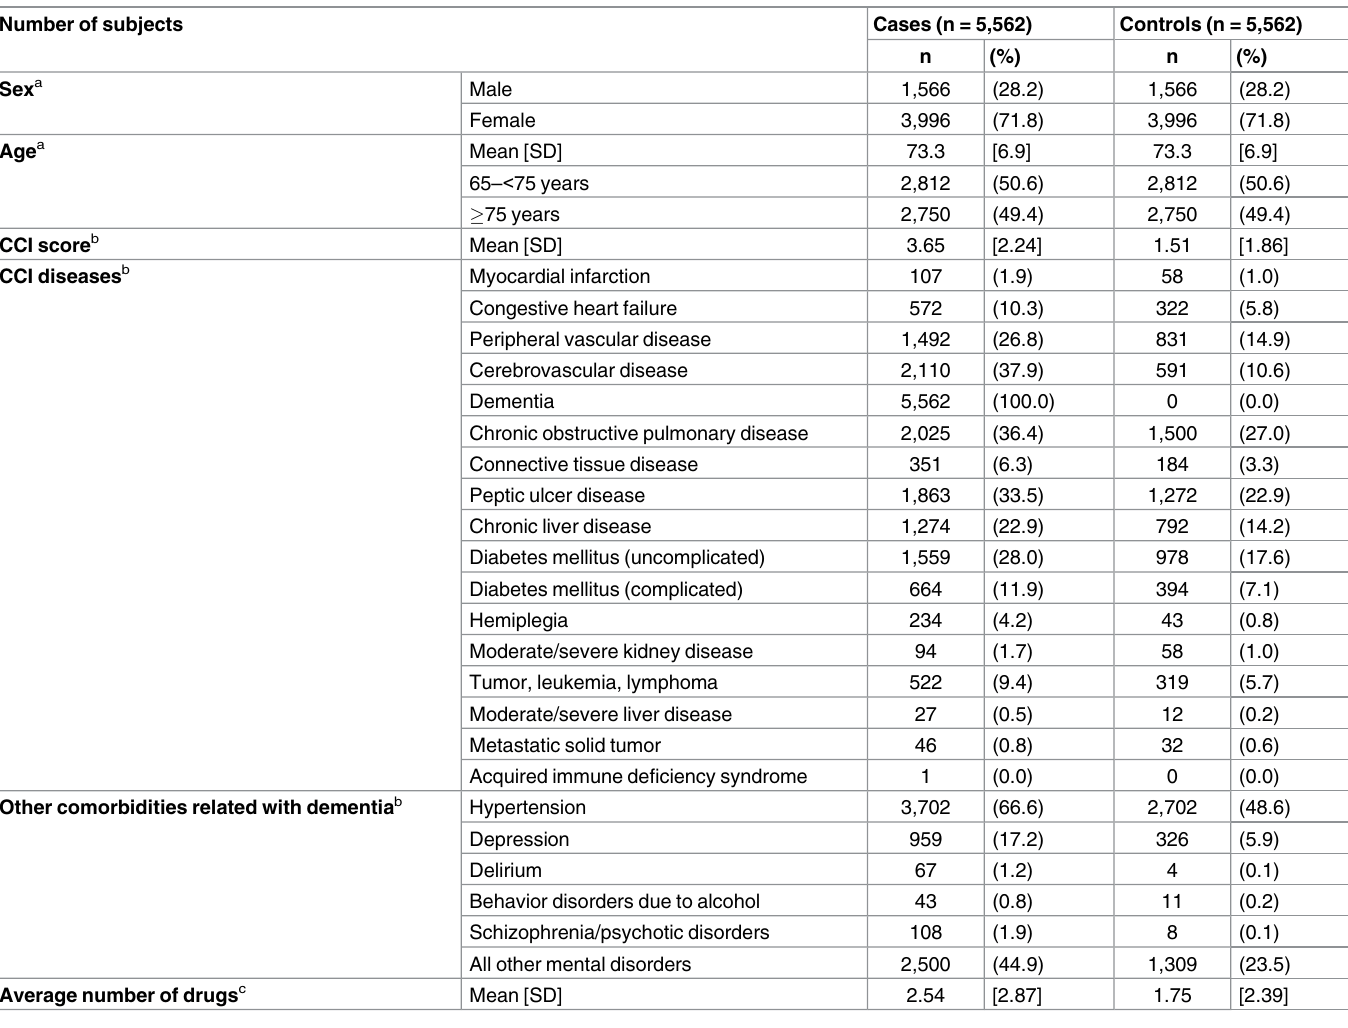
CCI: Charlson comorbidity index, DM: diabetes mellitus, SD: standard deviation. a The case and control groups had same distribution for age and sex due to matching. b The number of average prescribed daily drugs were estimated by adding all drugs prescription days in the look-back period and dividing the sum by